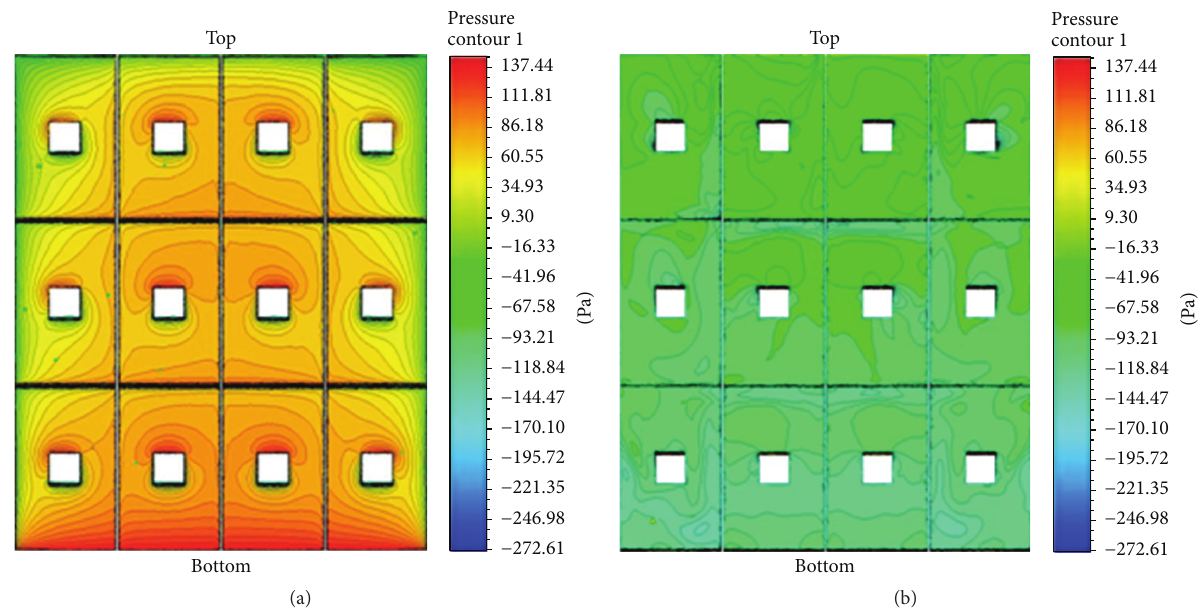
Figure 11: Static pressure (N/m 2 ) contours at panels with holes: (a) upwind side and (b) downwind side.